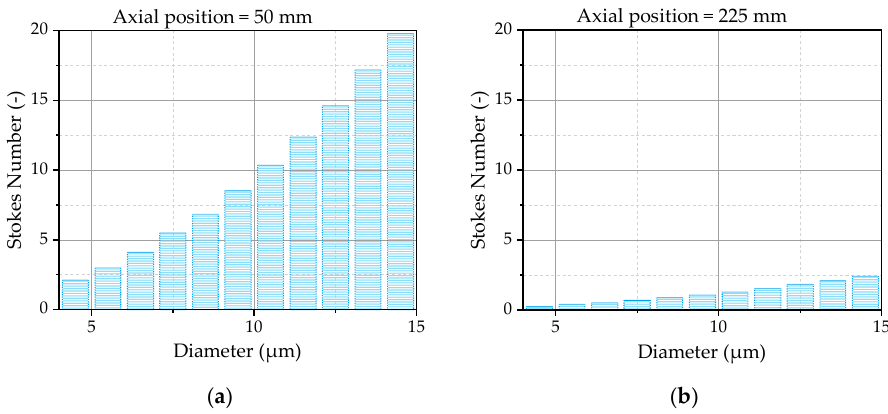
Figure 12. Stokes number of the simulated droplets as a function of the droplet diameter 50 mm ( a ) and 225 mm ( b ) downstream the nozzle exit averaged over the radial distance from − 3 mm to 3 mm.